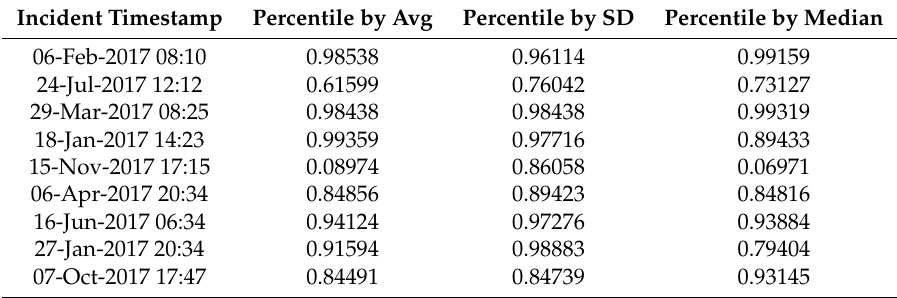
Table 10. Percentiles of Phase 2-Train incidents when sorted by sensor, day of week, and time of day. Incident Timestamp Percentile by Avg Percentile by